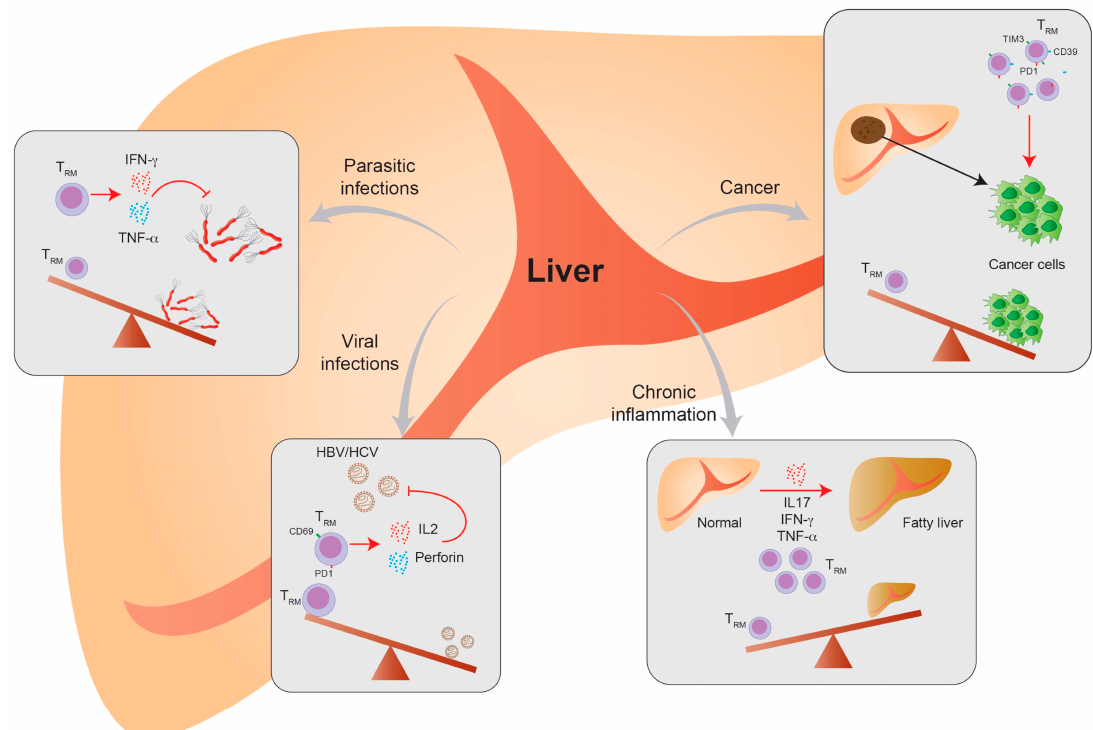
Figure 4. T RM cells play a central role during intrahepatic inflammation. In parasitic infections, T RM cells mediate cytotoxicity by the production of pro-inflammatory cytokines such as IFN- γ and TNF- α . During hepatitis virus infection, virus-specific T RM cells could be negatively correlated with virus titers by secreting high levels of IL-2 and perforin. Patients who attained viral control showed enriched intrahepatic T RM cell numbers. In sterile chronic inflammation of the liver, such as alcoholic or nonalcoholic steatohepatitis (ASH and NASH) T RM cells were associated with the overall pro-inflammatory cytokine milieu in the liver. Their expression of IL-17, IFN- γ and TNF- α contributes to disease progression. During the subsequent development of hepatocellular carcinoma (HCC), the CD103 + T RM cells showed opposing e ff ects. Patients with enriched numbers of these cells showed a better prognosis by mediating the anti-tumoral immune